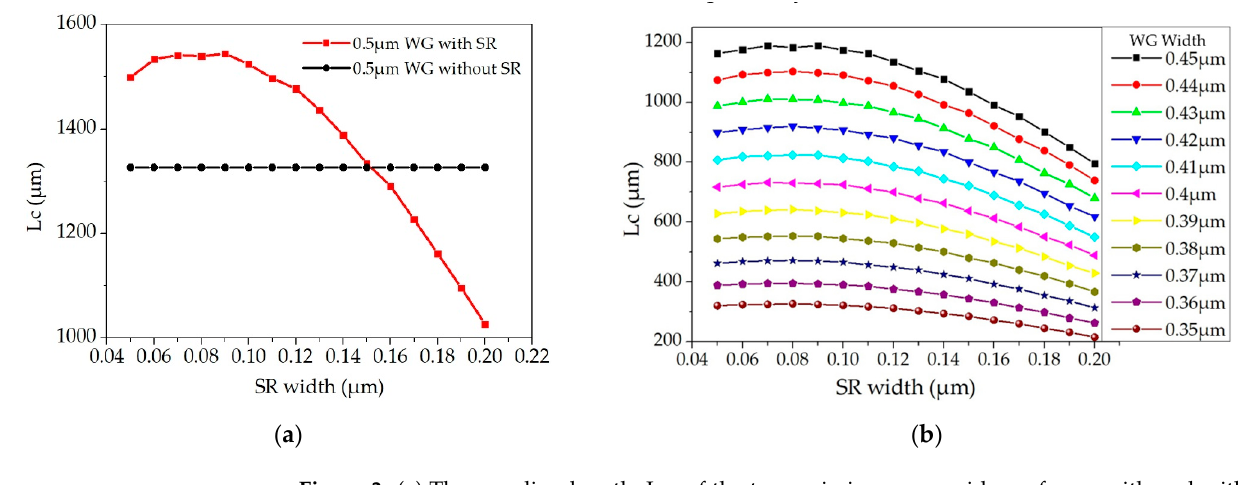
Figure 3. ( a ) The coupling length, L C , of the transmission waveguide performs with and without the silicon ribbon addi- tion. ( b ) The SR addition with various widths demonstrates transmission waveguide coupling under specific transmis- sion waveguide widths.